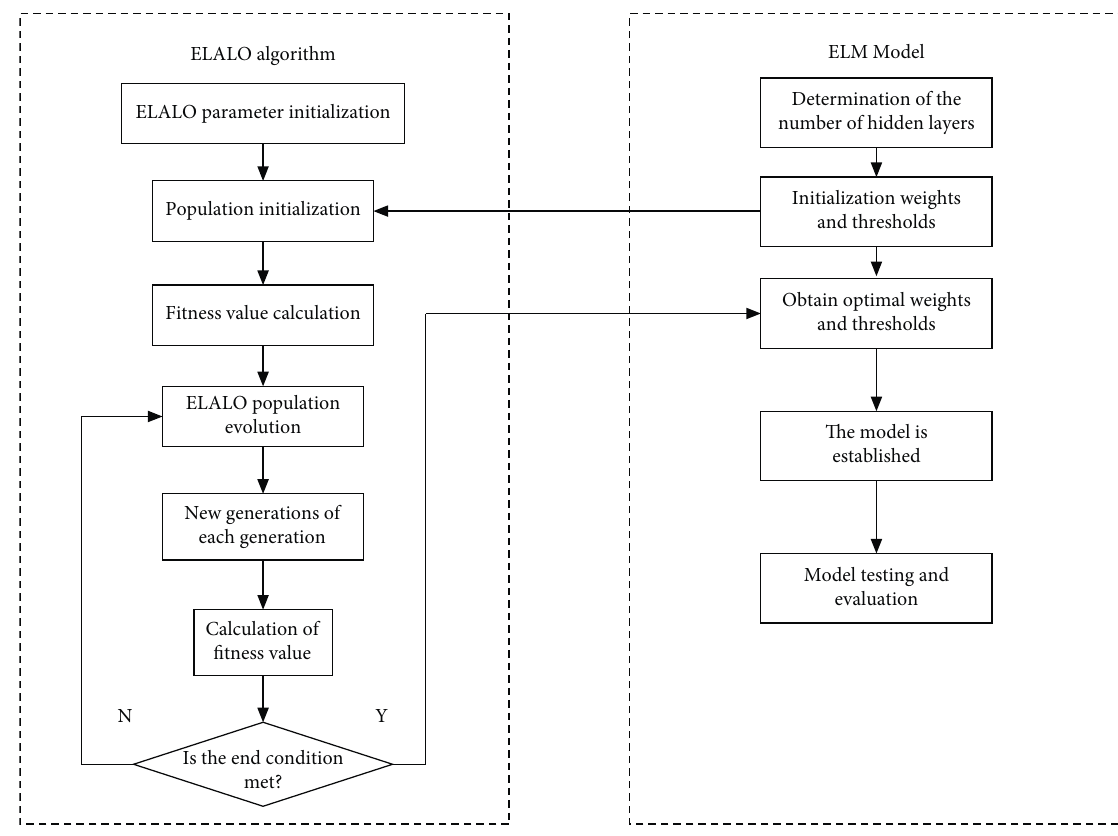
Figure 7: Flow chart of